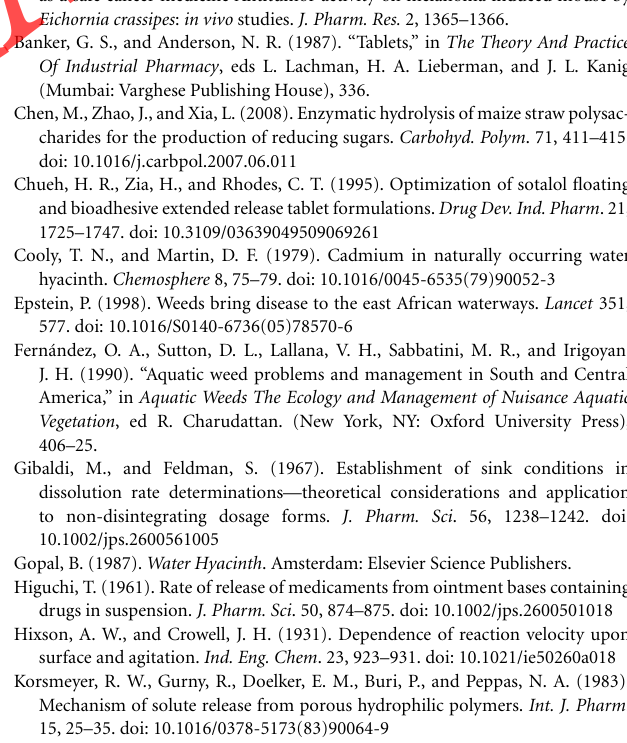
FIGURE 6 | Successive fractional dissolution time (minutes)